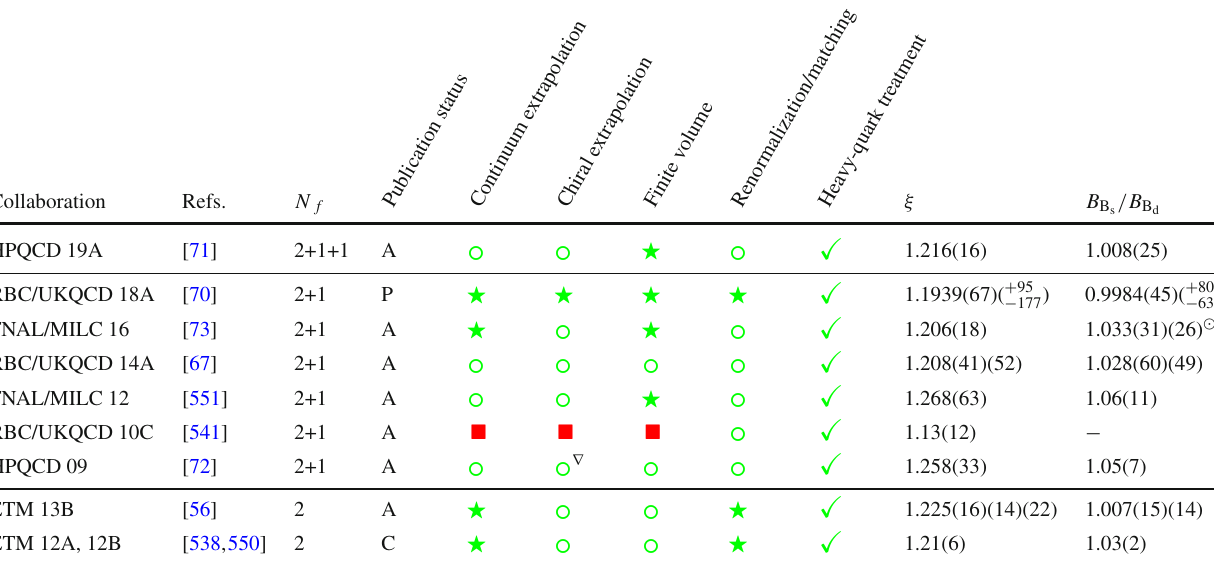
Table 44 Results for SU ( 3 ) -breaking ratios of neutral B d - and B s -meson mixing matrix elements and bag parameters